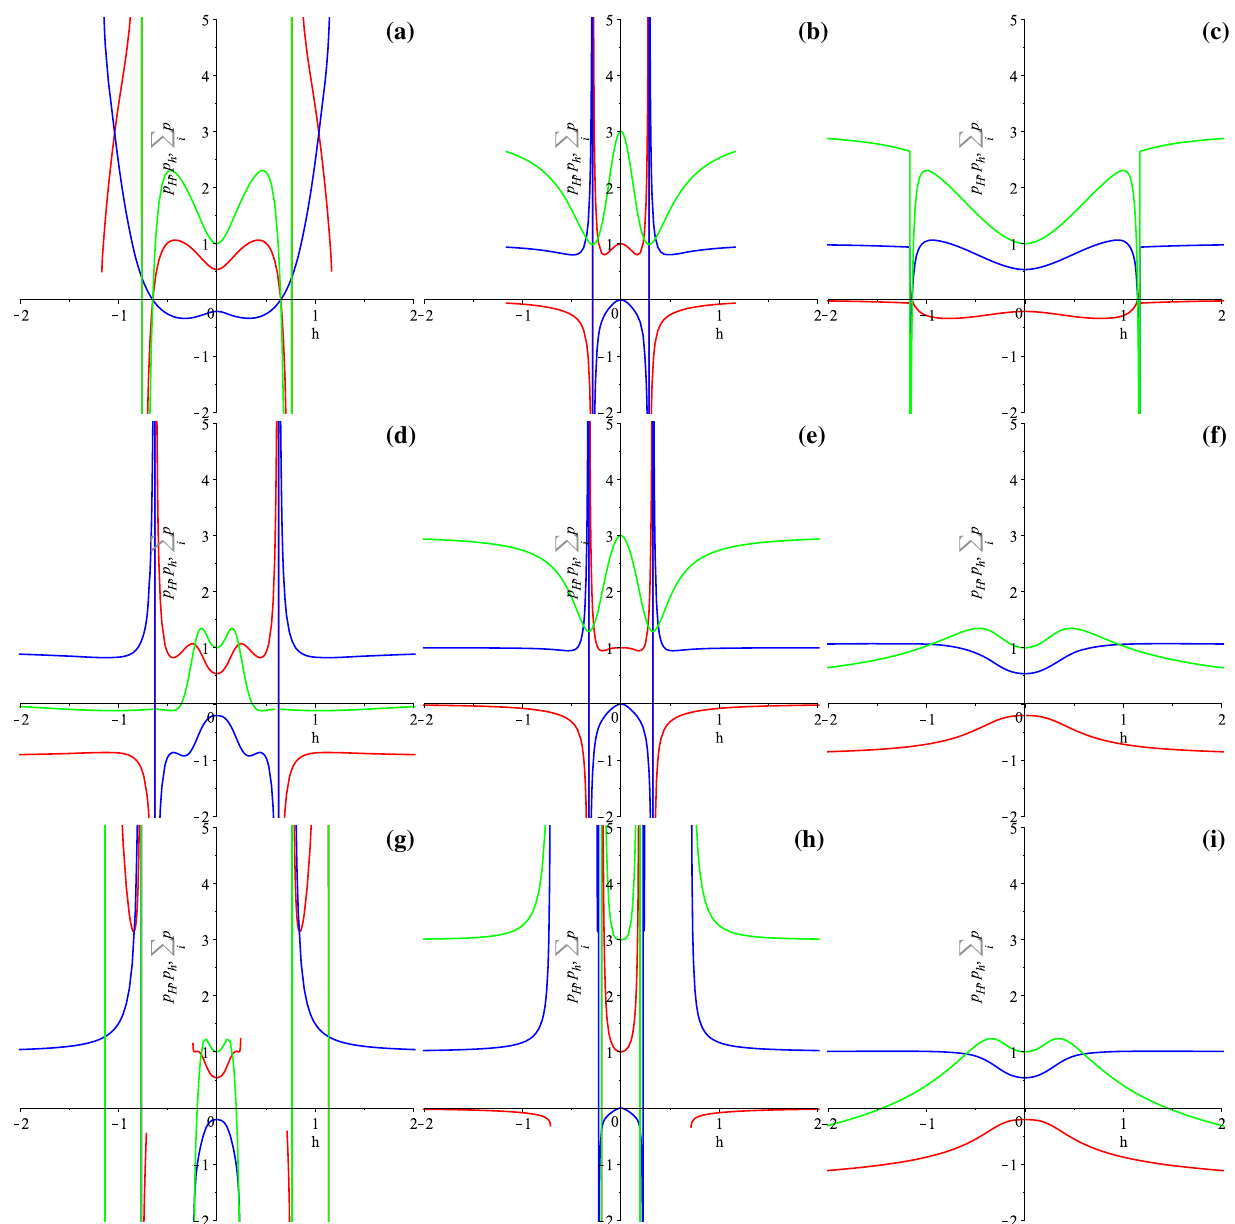
(cid:14) Fig. 4 p H , p h and p i graphs for vacuum D = 3 case: p H in red, (cid:14) p h in blue and p i in green; α < 0, β < 0 on a – c panels: H 1 branch on a panel, H 2 branch on b panel and H 3 branch on c panel; α < 0, β > 0, μ < 3 / 2 on d – f panels: H 1 branch on d panel, H 2 branch on e